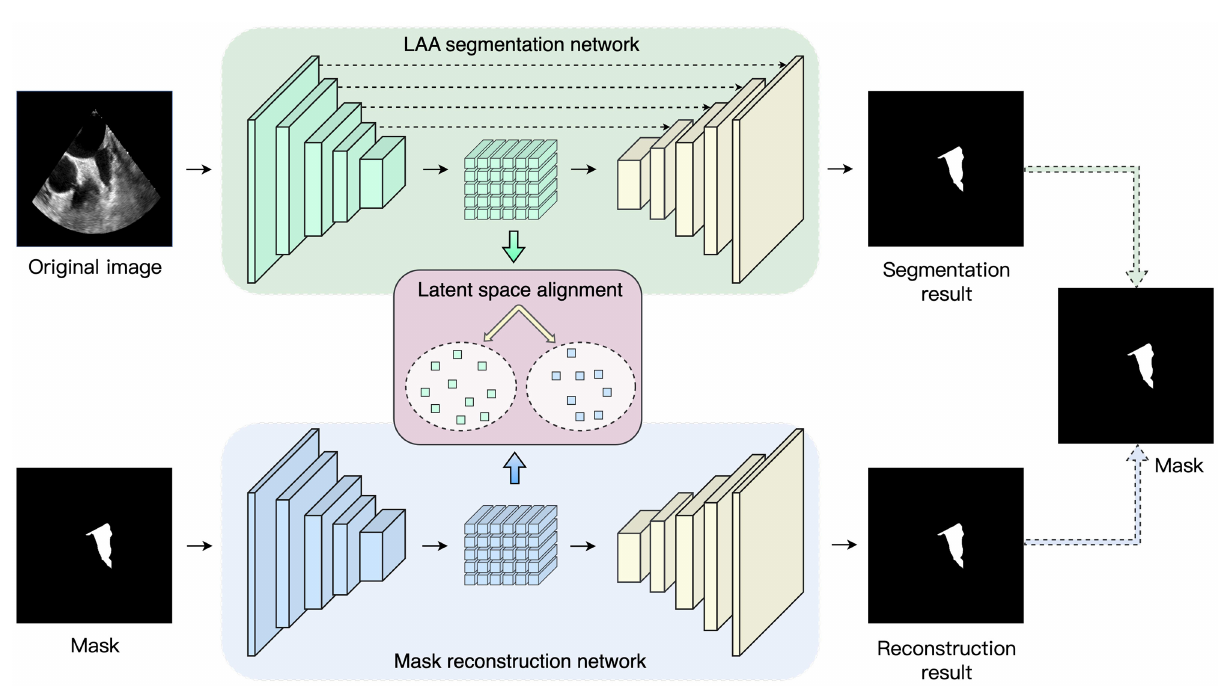
FIGURE1 Overview of the proposed network. The framework consists of three parts: LAA segmentation network, maks reconstruction network and latent space alignment.